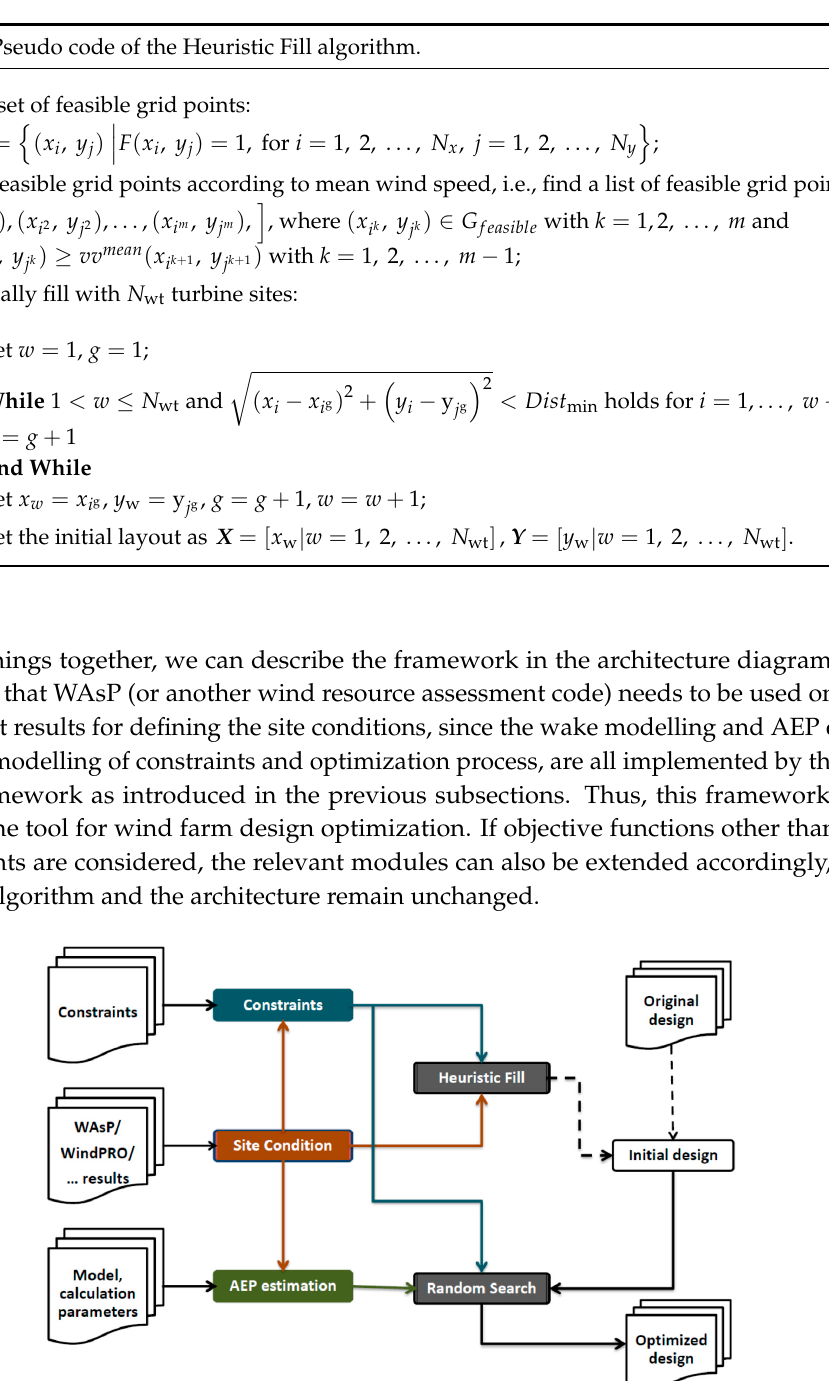
Figure 6. Original design of the anonymous wind farm in complex terrain.